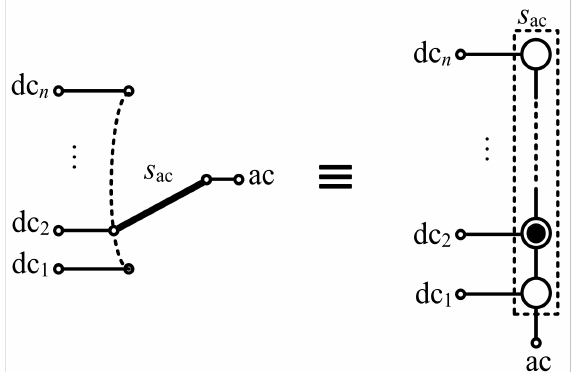
Figure 2. Functional model of an n -level NPC converter leg. The single-pole n -throw switch is represented with two alternative